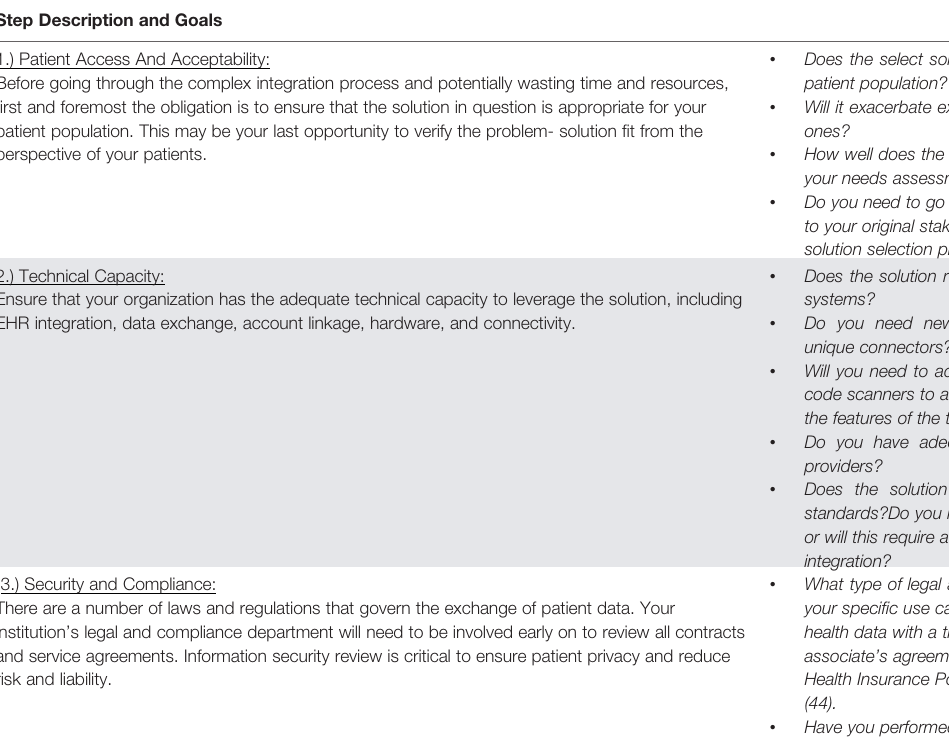
TABLE 1 | A Practical Digital Health IntegrationFframework in Eight